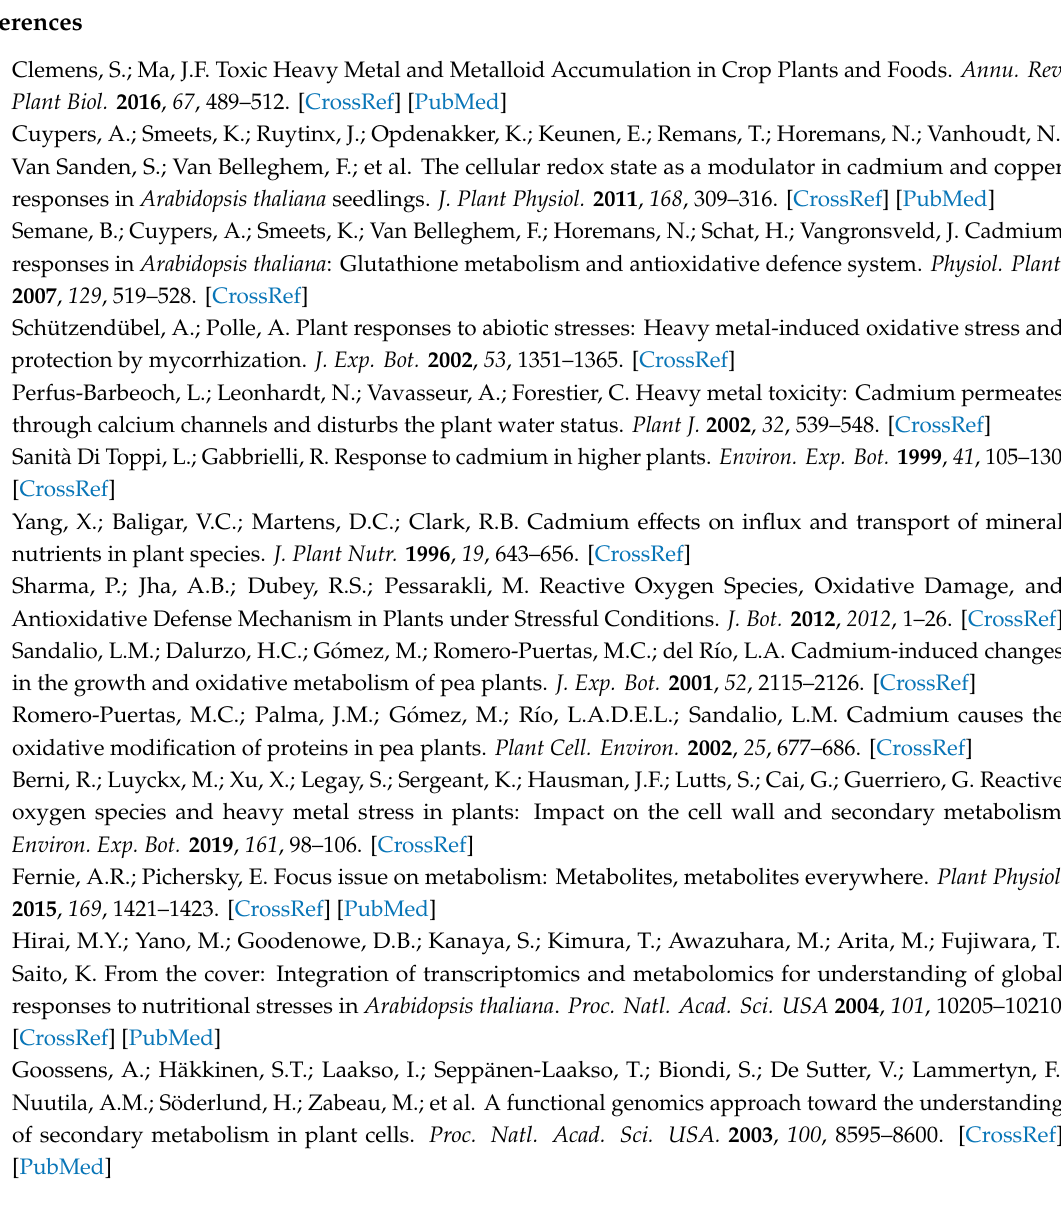
protocols. Table S3: Amino acids in stem tissue of M. sativa after long-term Cd exposure. Table S4: Relative content of primary metabolites in the leaves of M. sativa after long-term Cd